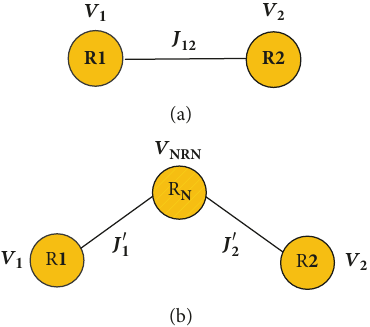
Figure 4: (a) First coupling scheme of two-order filter with none transmission zeros; (b) second coupling scheme of two-order filter in-line configuration with nonresonating nodes (patterned